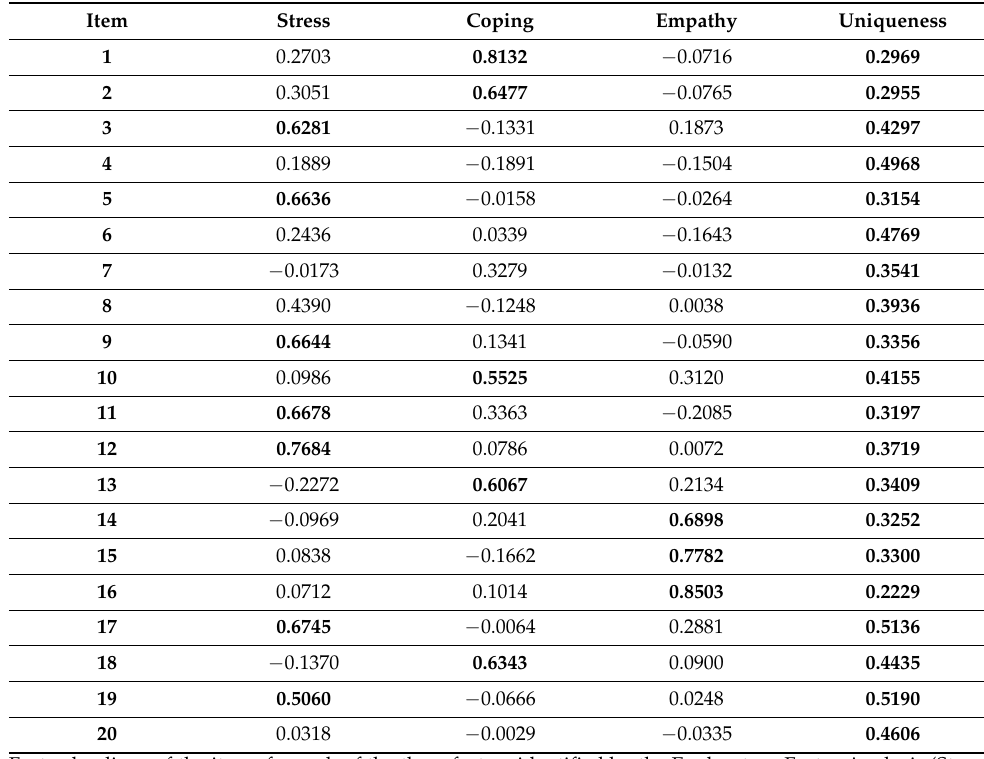
Table 3. Factor-loadings and Uniqueness after factor analysis.